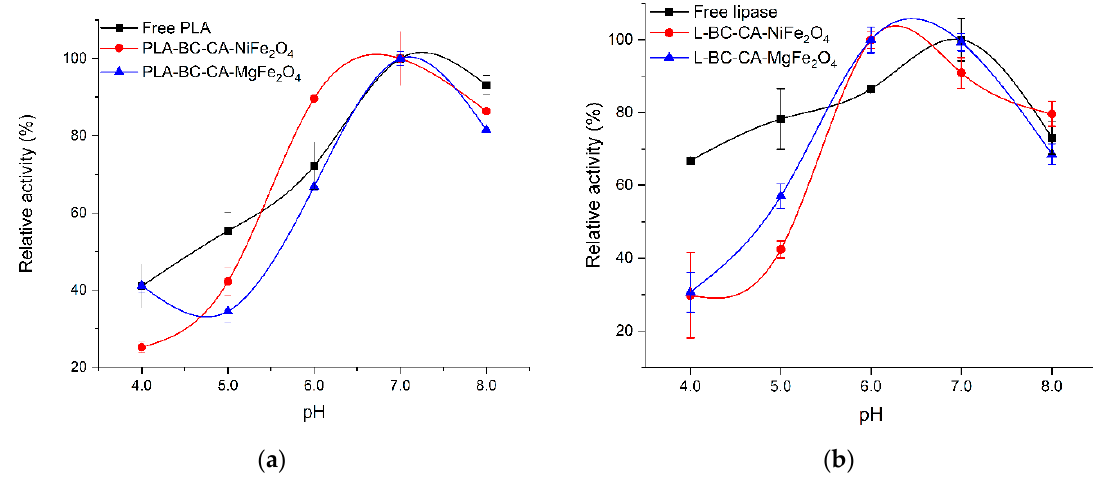
Figure 7. Effect of pH on the activity of free and immobilized carrier variants for phospholipase A1 ( a ) and lipase ( b ).